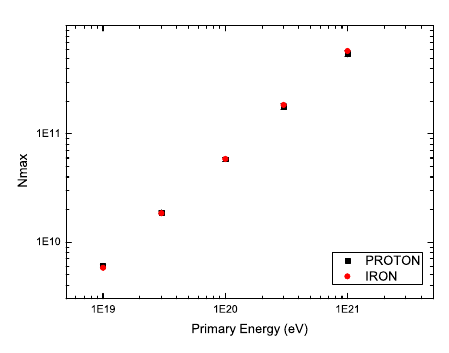
Figure 4. The maximum charged particles number N max as func- tion of the primary enery (proton, iron) of energy 10 20 eV.